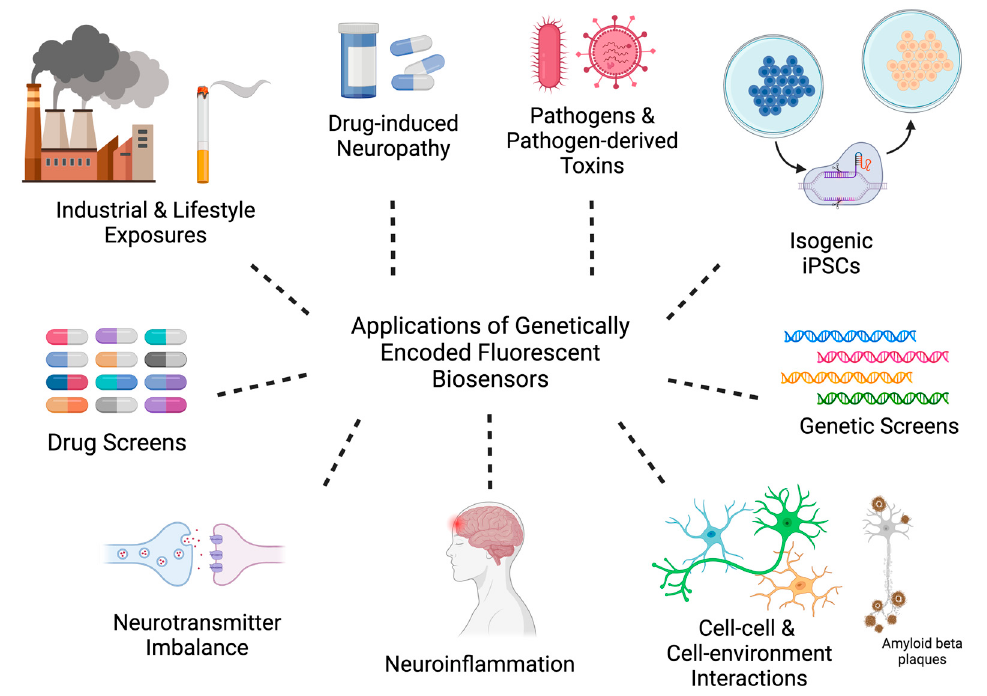
Figure 2. Overview of GEFB pre-clinical applications.